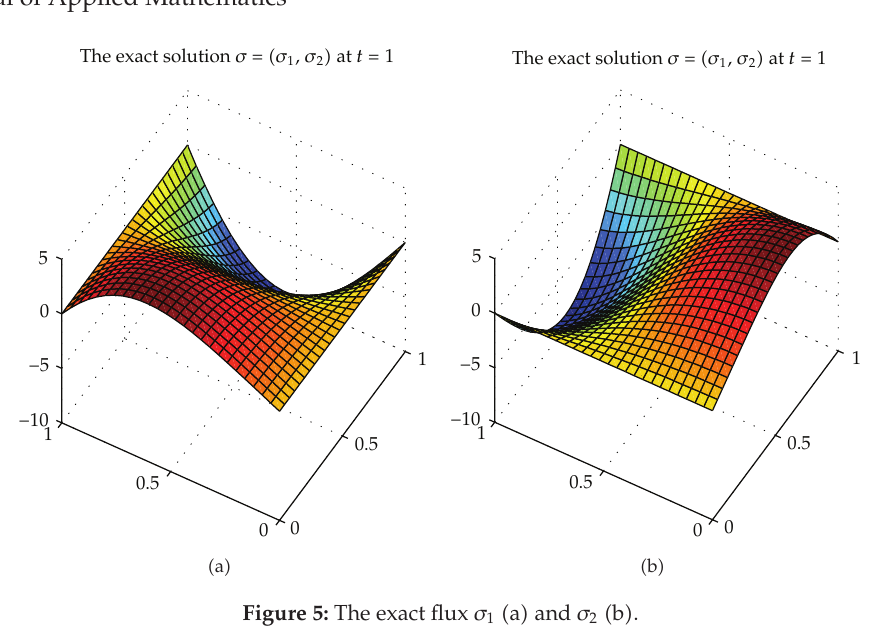
Figure 5: The exact flux σ 1 (cid:3) a (cid:4) and σ 2 (cid:3) b (cid:4) .